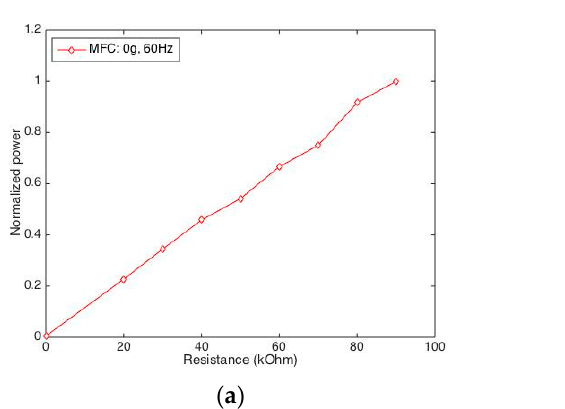
( d ) Figure 7. Electromechanical characteristics from MFC and PPA under resonant excitations. ( a ) Volt- age vs. strain for MFC under 60 Hz; ( b ) Power vs. strain for MFC under 60 Hz; ( c ) Voltage vs. strain for PPA under 120 Hz; ( d ) Power vs. strain for PPA under 120 Hz. 2.3.4. Rational Resistance Determination Herein, we observe how the resistance load affects the harvested electric power, given that the excitation frequency is set as its approximate resonant frequency. In Figure 8, for comparison, all the generated powers of the cases are normalized within the unit range (0–1). The normalized powers of the MFC are listed with different resistances from 0 to 90 kOhm, as shown in Figure 8a. We find the electric power of the MFC almost in-